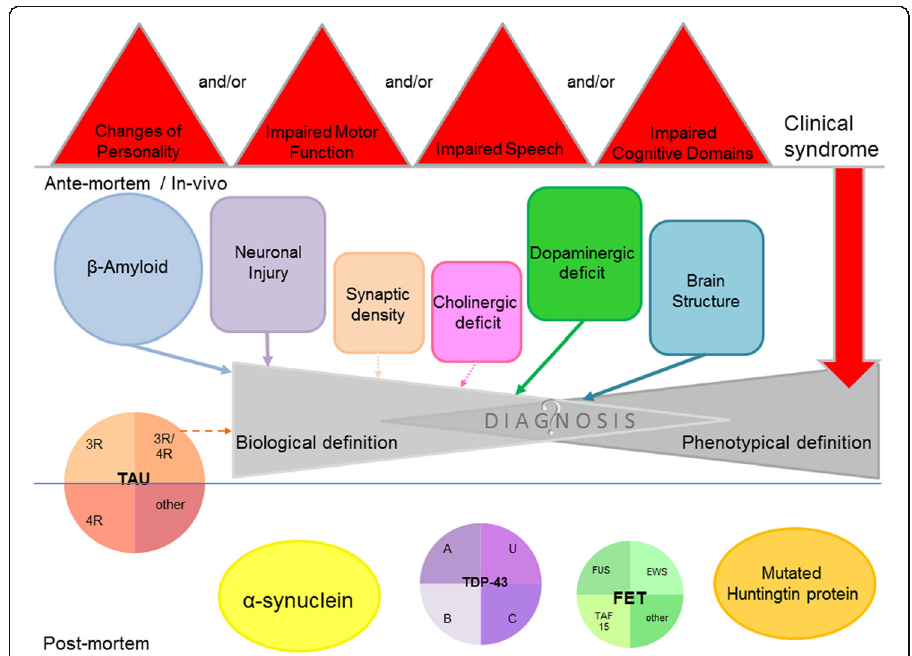
Fig. 9 Overview of available imaging biomarkers detecting characteristics of neurodegenerative diseases ante-mortem/in-vivo and histopathological hallmarks which are/were, so far, only detectable post-mortem. Furthermore, the shift from a phenotypical to a biological definition of neurodegenerative diseases as